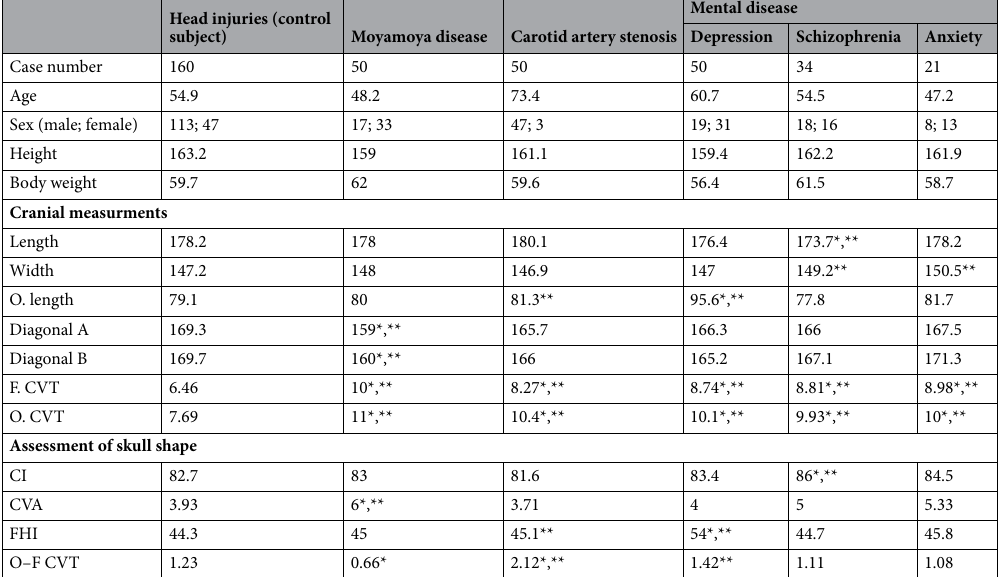
Table 1. The average value in a set of physical and cranial measurments according to primary diseases. CI cephalic index, CVA cranial vault asymmetry, CVT cranial vault thickness, F frontal, FHI flat head index, O occipital, O–F occipital–frontal, Notes showing significant difference (P < 0.05%) comparing to control subjects in univariate (*) and multivariate (**)